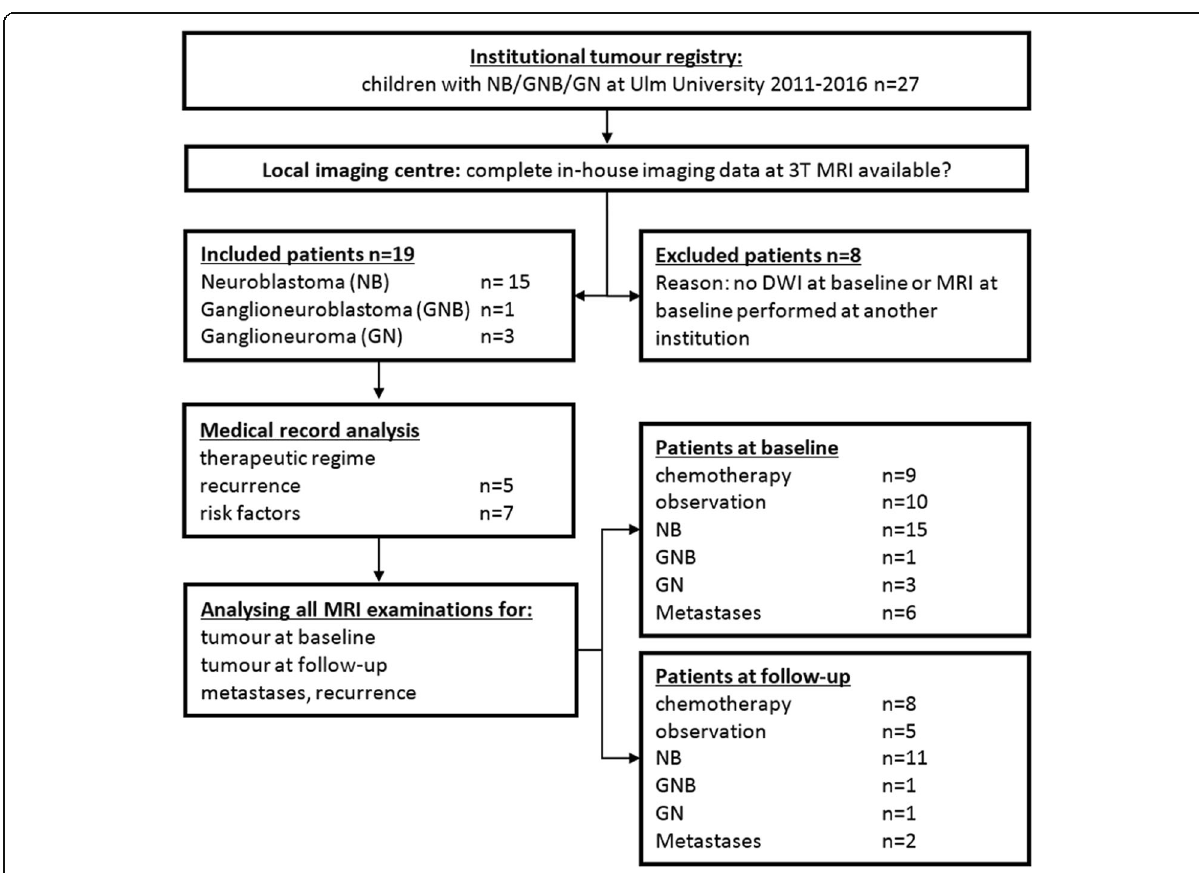
Fig. 1 Flowchart highlighting the process of patient selection and the patient subgroups for data